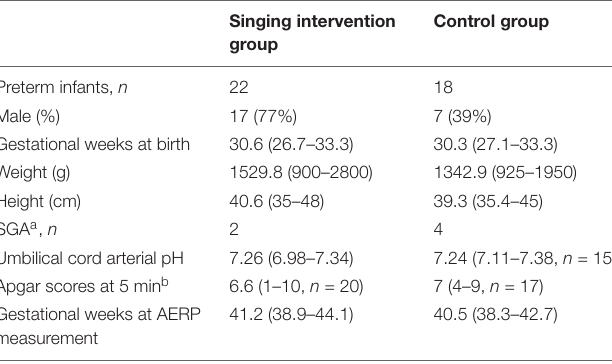
TABLE 1 | The participant information of the preterm infants (mean and